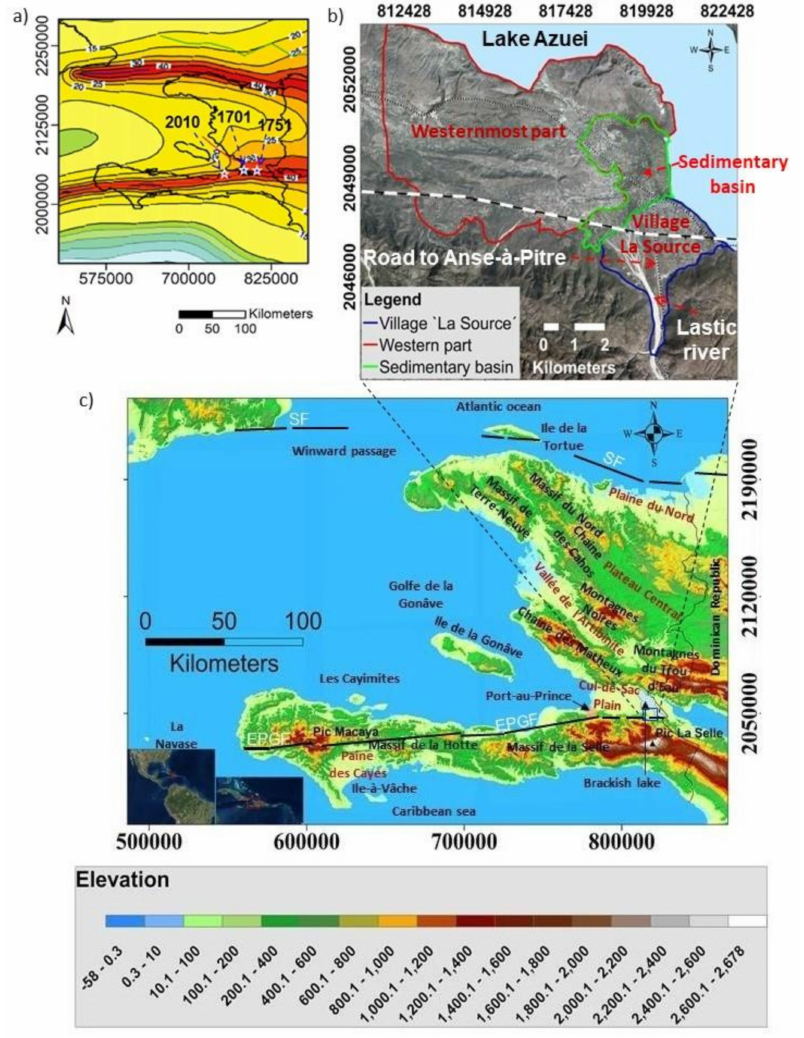
Figure 1. ( a ) Seismic hazard map for Haiti with 10% exceedance probability in 50 years. Large historical earthquakes and higher peak ground acceleration are located on/near Enriquillo Plantain Garden Fault (EPGF) and Septentrional Fault (SF). ( b ) The Fond Parisien area with the village “La Source” outlined in blue and the Cul-de-Sac plain shown in green; modified from Frankel et al. [7]. ( c ) Topographic map of Haiti showing the location of the district of Fond Parisien in Haiti. SF and EPGF are respectively Septentrional Fault Enriquillo Pantain Garden